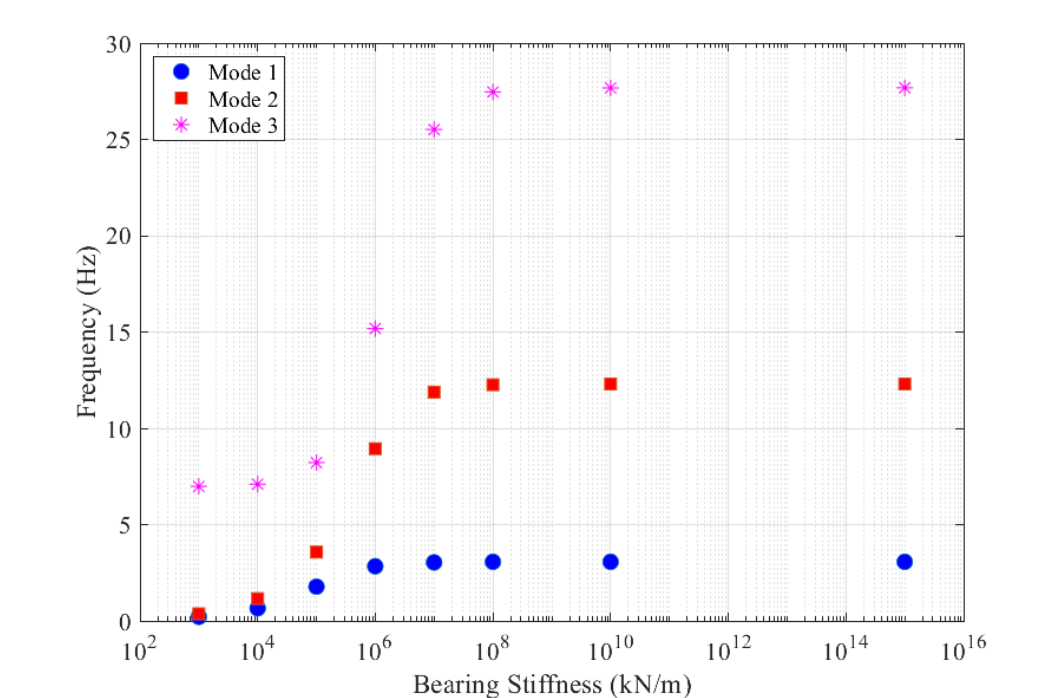
Figure 7. Variation of the bridge natural frequencies with the bearing